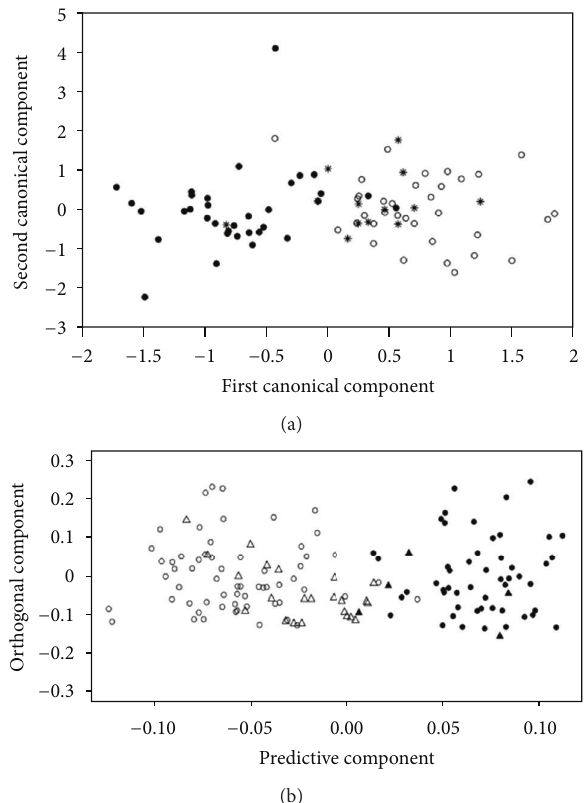
Figure 3: (a) Clustering of CMPG (Carr-Purcell-Meiboom-Gill spinechosequence)[83]serumspectraofCDpatients(filledcircles) and controls (open circles). The discriminant model between the twogroupswascalculatedusingacombinationofpartialleastsquare [89] and (regularized) canonical analysis [90] (PLS-RCC) and was validated using cross-validation. The CPMG spectra of 13 (out of the 34) CD patients after 12 months of gluten-free diet were then projected into the discriminant space of the model (stars) and were assigned to the CD or the healthy group applying a support vector machine [91] classifier (SVM). (b) Clustering of overt CD patients (open circles) and healthy controls (filled circles) obtained with CPMG serum spectra. The discriminant model was calculated using orthogonal partial least square [92] (OPLS) and validated using double cross-validation [93]. The CPMG spectra of 29 potential CD patients were then projected in the model (triangles) and filled or not according to the results of an SVM classifier. Adapted with permission from [49, 50]. Copyright (2009 and 2011) American Chemical